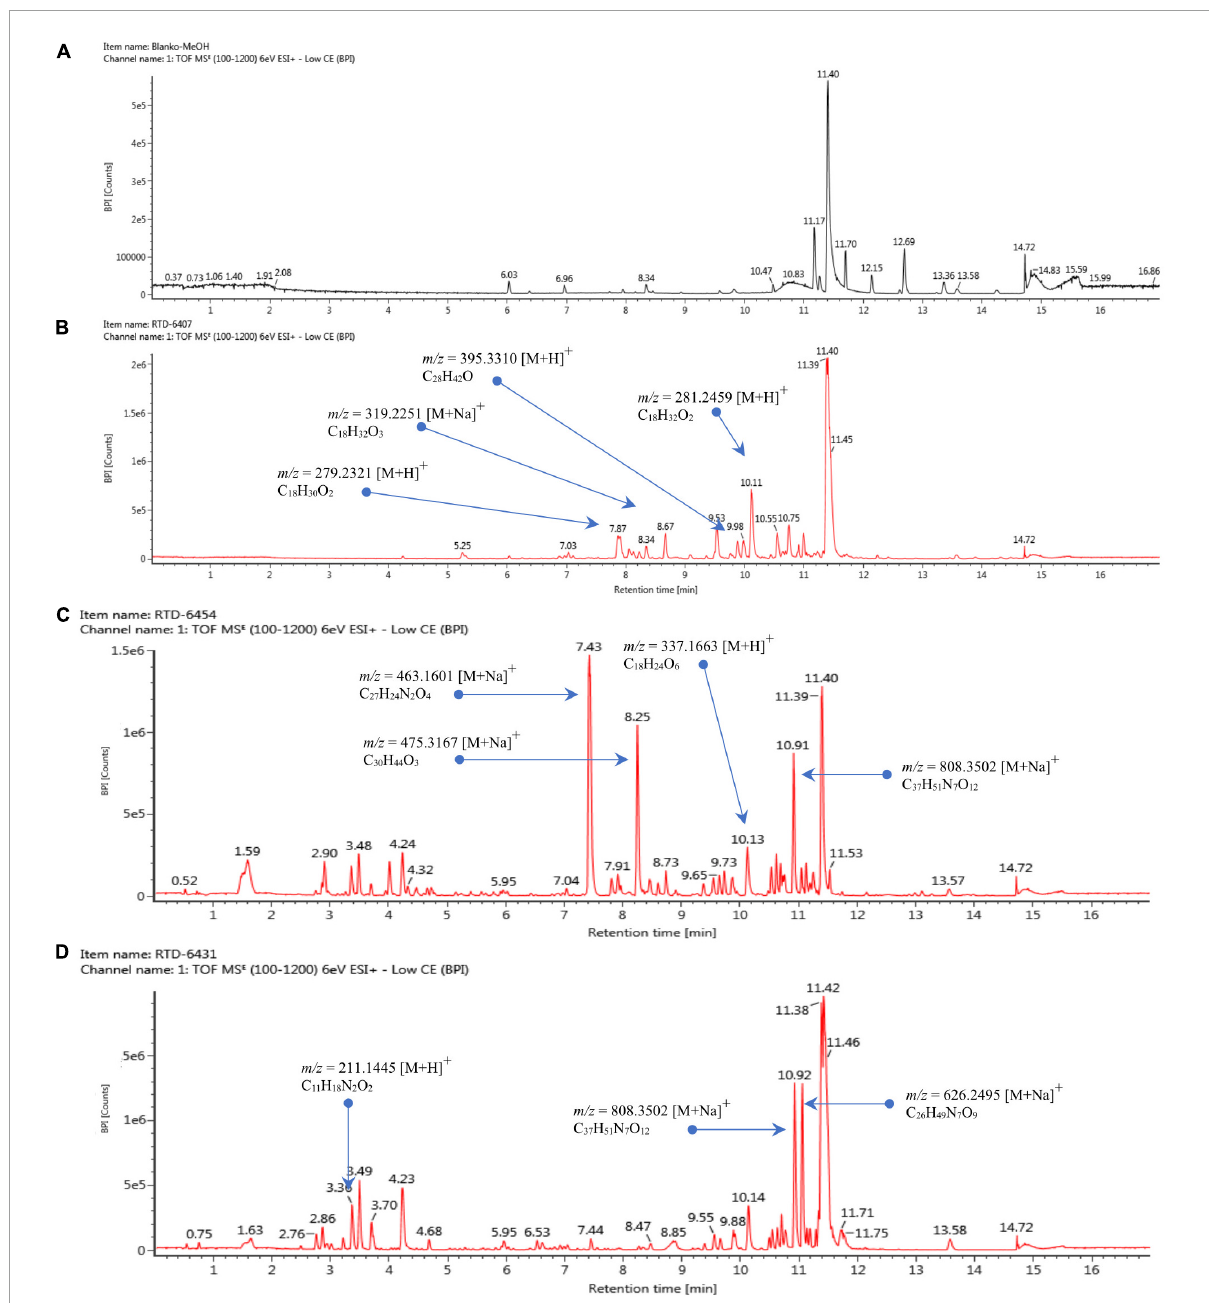
FIGURE4 Liquid chromatography–mass spectrometry chromatogram of baseline (A) , extracted isolates Trichoderma sp. 6407 (B) , Phyllosticta sp. 6454 (C) , and Neopestalotiopsis sp. 6431 (D) .